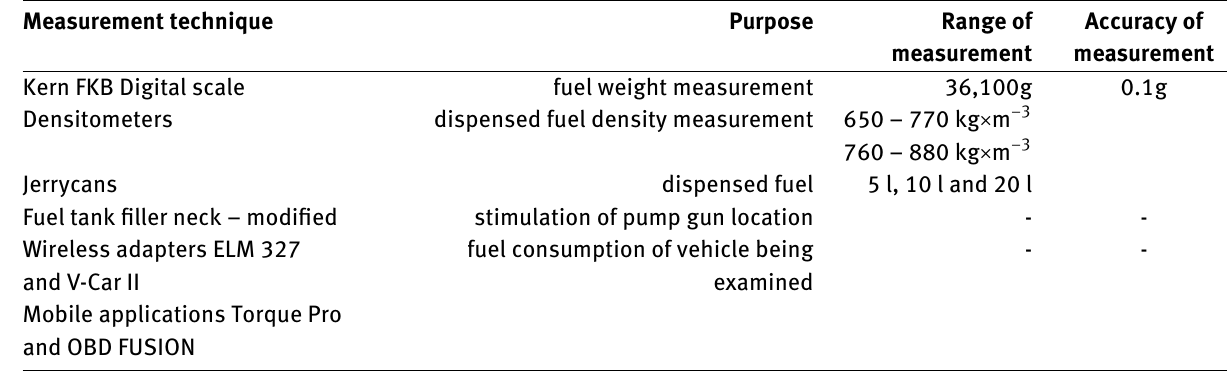
Table 3: Specifications of measurement